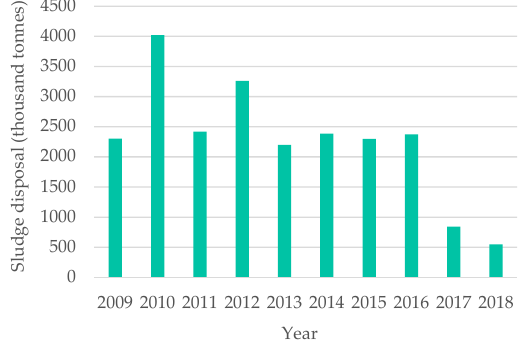
Figure 2: Sludge disposal in Europe—agricultural use [54] Figure 2. Sludge disposal in Europe—agricultural use Eurostat, [56].